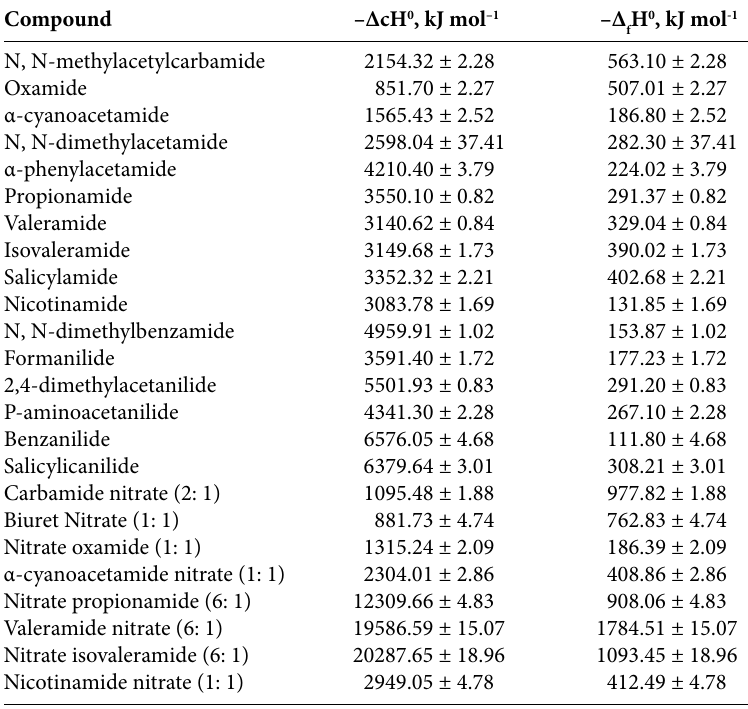
Table 1. Standard enthalpies of combustion and formation of amides and their derivatives